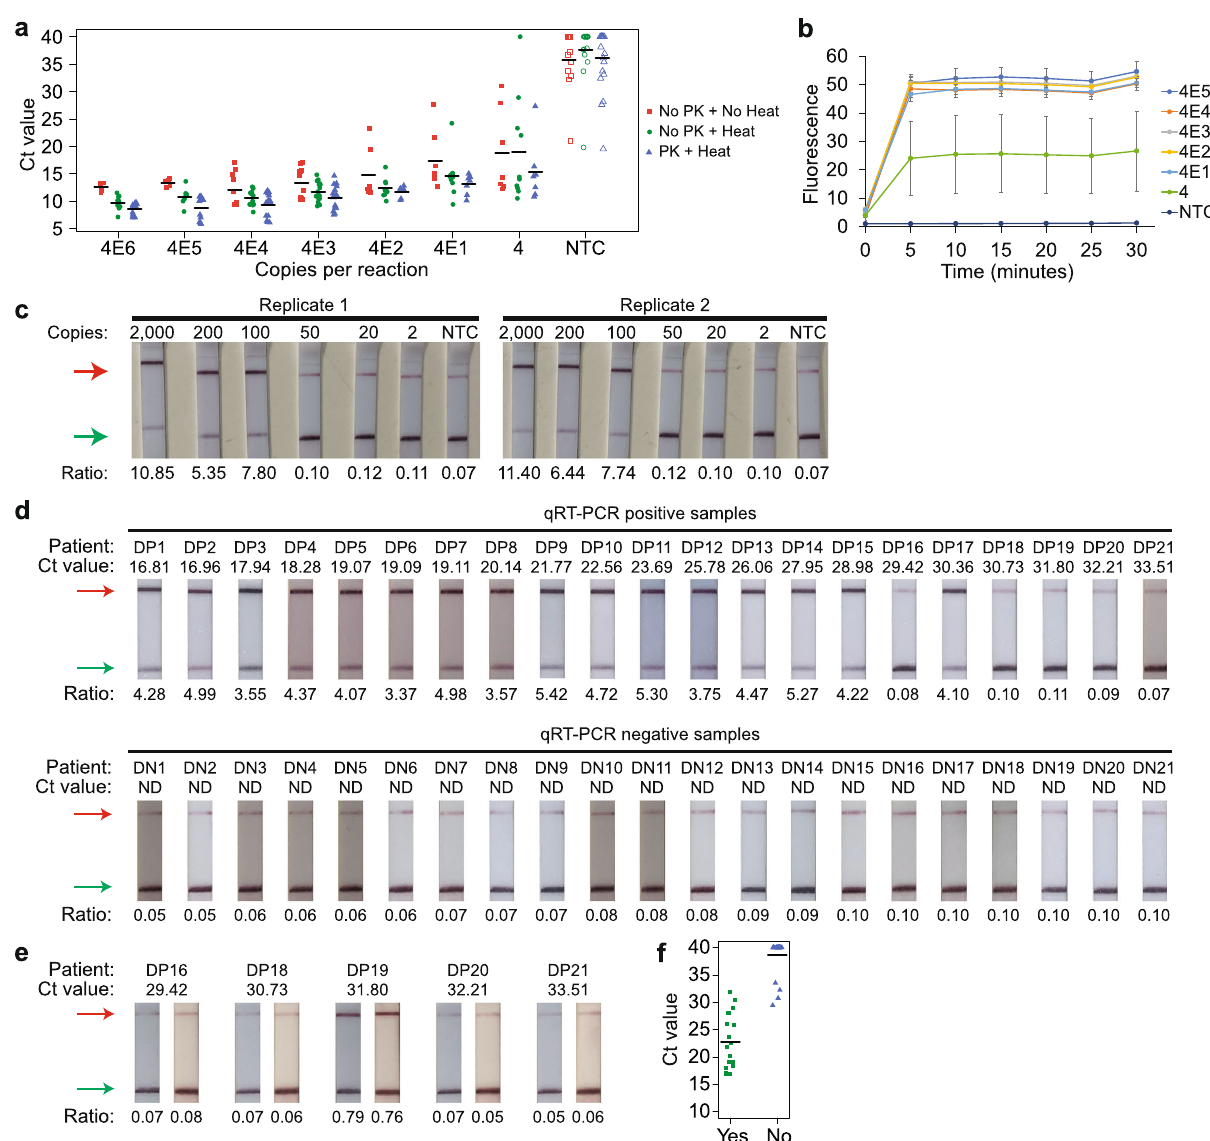
Fig. 9 Application of our VaNGuard assay on crude samples. a Strip chart showing the effect of proteinase K and heat treatment on RT-LAMP when different copies of S-gene-expressing lentivirus spiked into saliva were used as input. The black horizontal bars among the data points in the strip chart represent the mean (no PK + no heat: n = 5 [4E5-4E6], 7 [4-4E2], 10 [4E4], or 12 [4E3 and NTC]; no PK + heat: n = 7 [4E5], 9 [4E6], 10 [4-4E2], 15 [4E4], or 17 [4E3 and NTC]; PK + heat: n = 7 [4-4E2], 11 [4E5], 13 [4E6], 15 [4E4], 18 [4E3], or 20 [NTC] biological replicates). b Evaluating VaNGuard test sensitivity to unpuri fi ed pseudovirus. The enAsCas12a enzyme was complexed with both the S2 and S6 hybrid guides. Different copies of lentivirus spiked into saliva were treated with proteinase K and heat before being used as input to the quasi-one-pot reaction. Fluorescence measurements were taken at 5-minute intervals using a microplate reader. Data represent mean±s.e.m. ( n = 4 biological replicates). c Evaluating VaNGuard test sensitivity to unpuri fi ed SARS-CoV-2. The enAsCas12a enzyme was complexed with both the S2 and S6 hybrid guides. Different copies of the coronavirus produced in Vero E6 cells were spiked into clinically negative UTM, treated with proteinase K and heat, and then used as input to the quasi-one-pot reaction. The Cas detection step was carried out for 5min before a dipstick was added to each reaction tube. d Clinical evaluation with NP swab samples. A Ct value of 30 was estimated to be equivalent to 500 copies of the virus. The enAsCas12a enzyme was complexed with both the S2 and S6 hybrid guides. Each sample was treated with proteinase K and heat before 2 µ l was used as input to the quasi-one-pot reaction. The Cas detection step was carried out for 5min before a dipstick was added to each reaction tube. e Re-test of misclassi fi ed NP swab samples using twice the reaction volume. 4 µ l of each sample was used as input to the quasi-one-pot reaction. Overall, for the direct patient samples, the lateral fl ow assay gave 0 false positives and 4 false negatives (DP16, DP18, DP20, and DP21). f Strip chart summarizing the results from the clinical evaluation of our VaNGuard test using unpuri fi ed NP swab samples. “ Yes ” indicates that the samples emerged positive in our test, while “ No ” indicates that the samples emerged negative. Source data are available in the Source Data fi